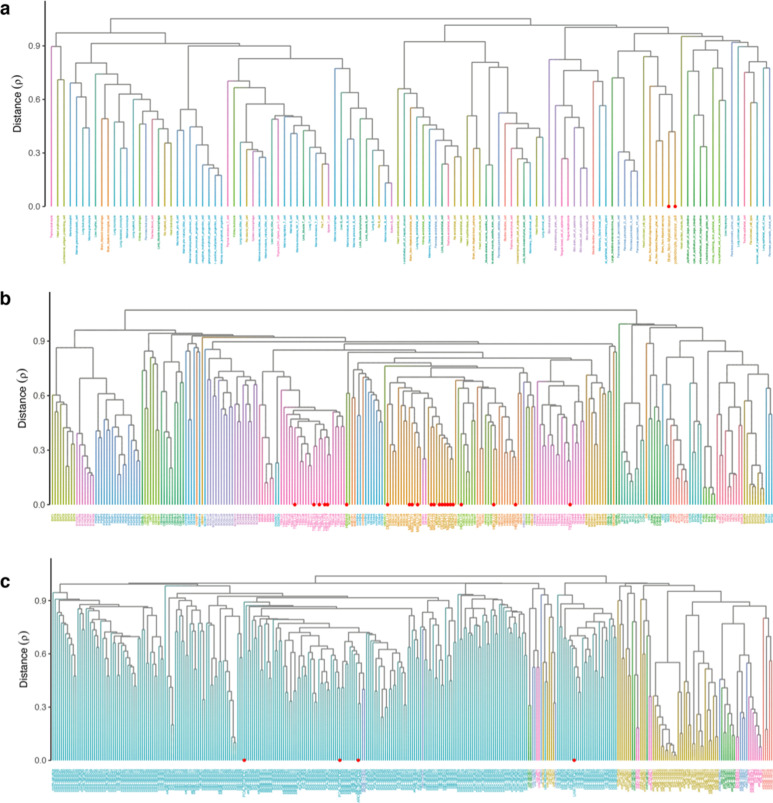
Hierarchical clustering of cell types using ESμ.Dendrogram of cell types clustered using average linkage of ESμ Pearson’s correlation. Dendrograms are shown for (a) Tabula Muris; (b) Mouse Nervous System; and (c) Hypothalamus datasets. Cell types highlighted by red points (positioned at leaf nodes) passed the Bonferroni significance threshold in the BMI GWAS enrichment analysis.